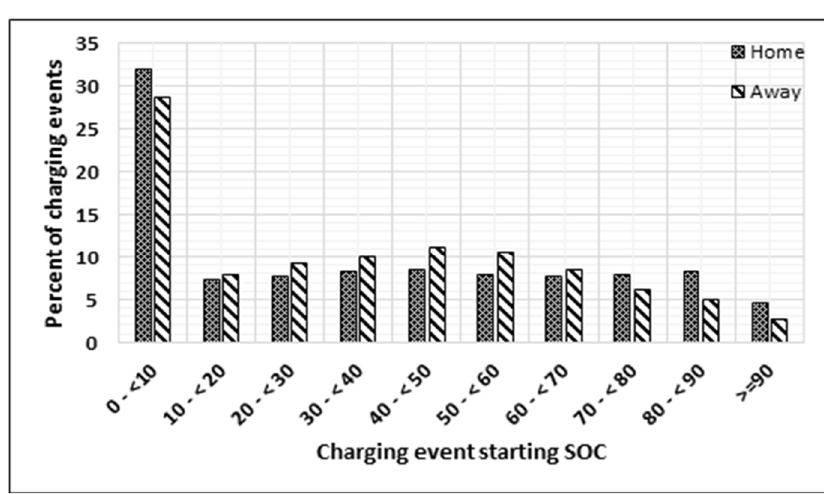
Figure 7. Chevrolet battery state of charge at the start of charging events [31].